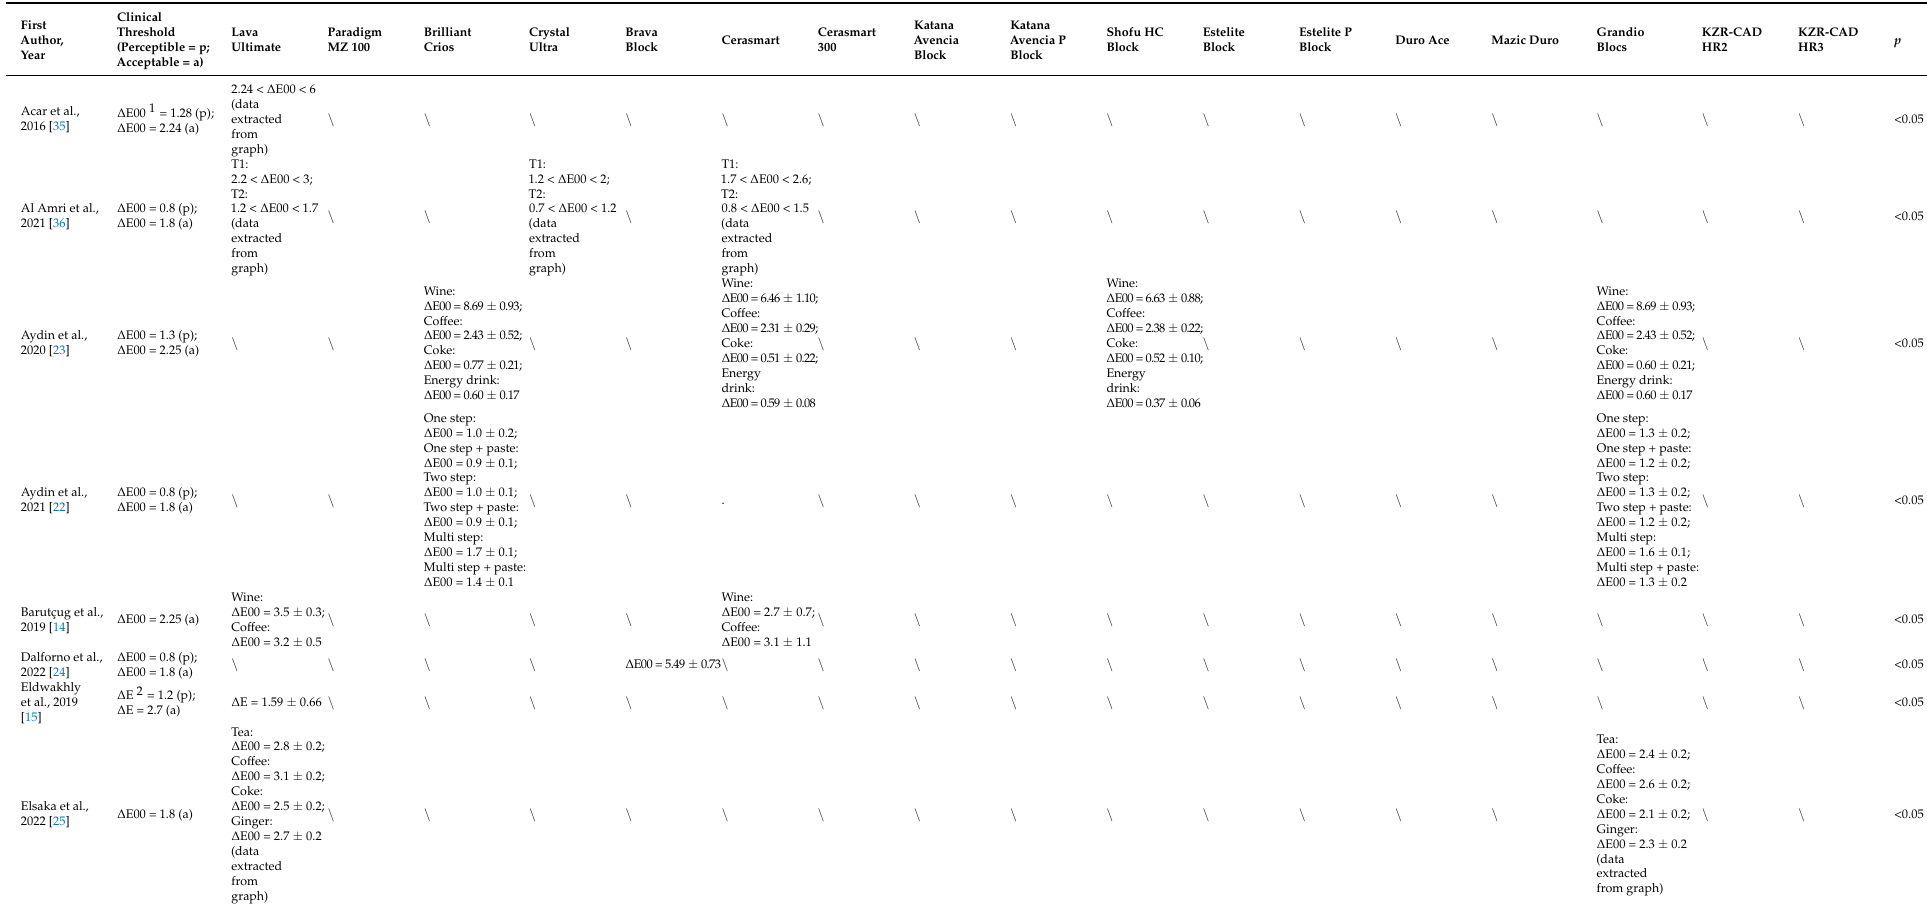
Table 4. Color change of CAD/CAM composite blocks investigated by the papers included in the current review. (1: ∆ E00 = color change obtained with CIEDE2000 formula; 2: ∆ E= color change value obtained with CIELAB formula).